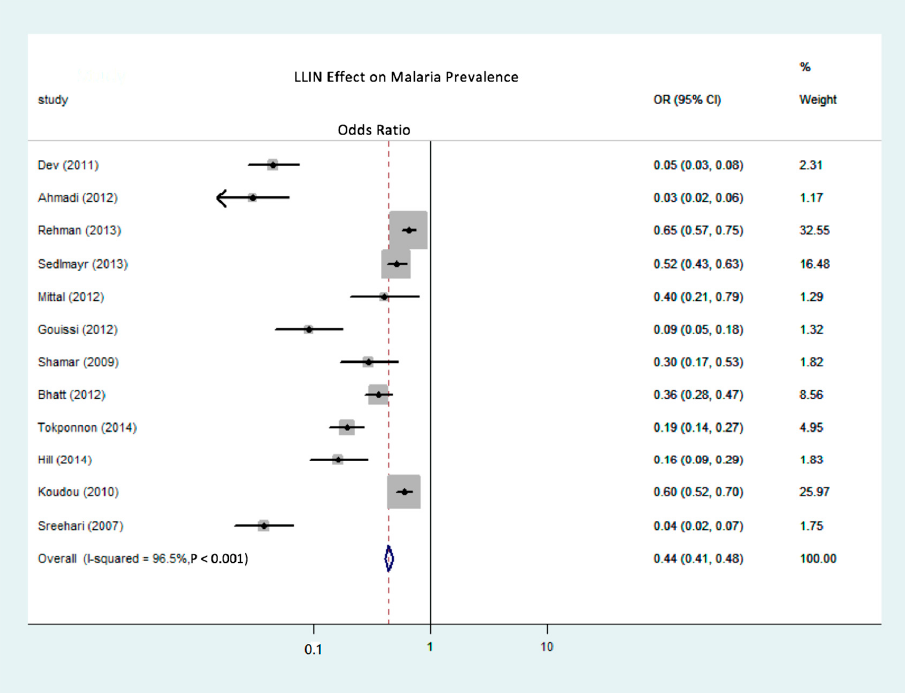
Figure 2. Forest plot of the meta-regression analysis of the odds ratio of the reduction of malaria prevalence due to the use of LLINs. (The row-like symbol for Ahmadi (2012) indicates that the lower limit of 95% CI for the study is so low that it goes beyond the chart area.).